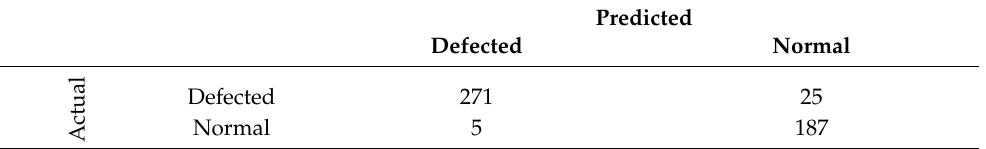
Table 3. Confusion matrix for the inspection procedure with Chan–Vese parameters µ = 4 and ν =